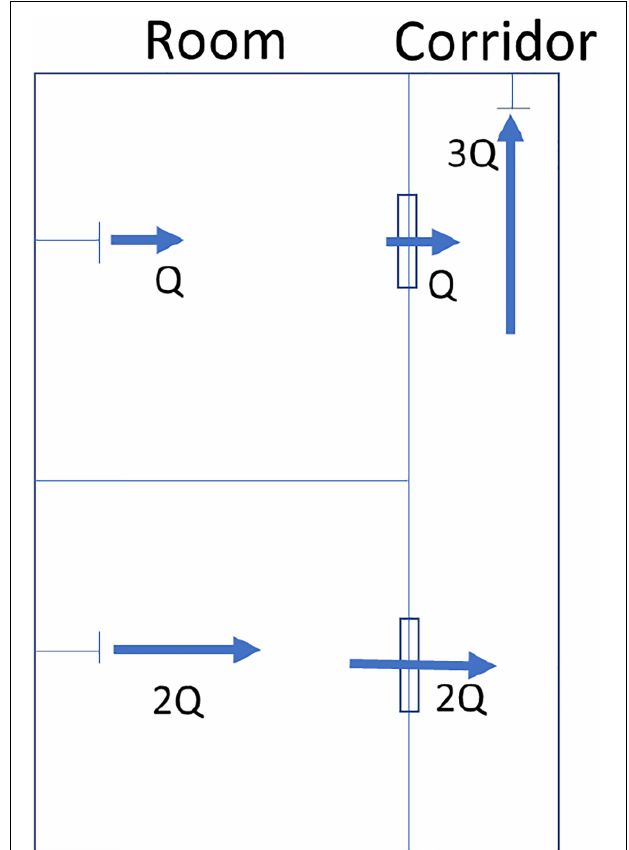
FIGURE 4 | Typical Swedish design of office buildings; ( → ) and (Q) denote airflow.